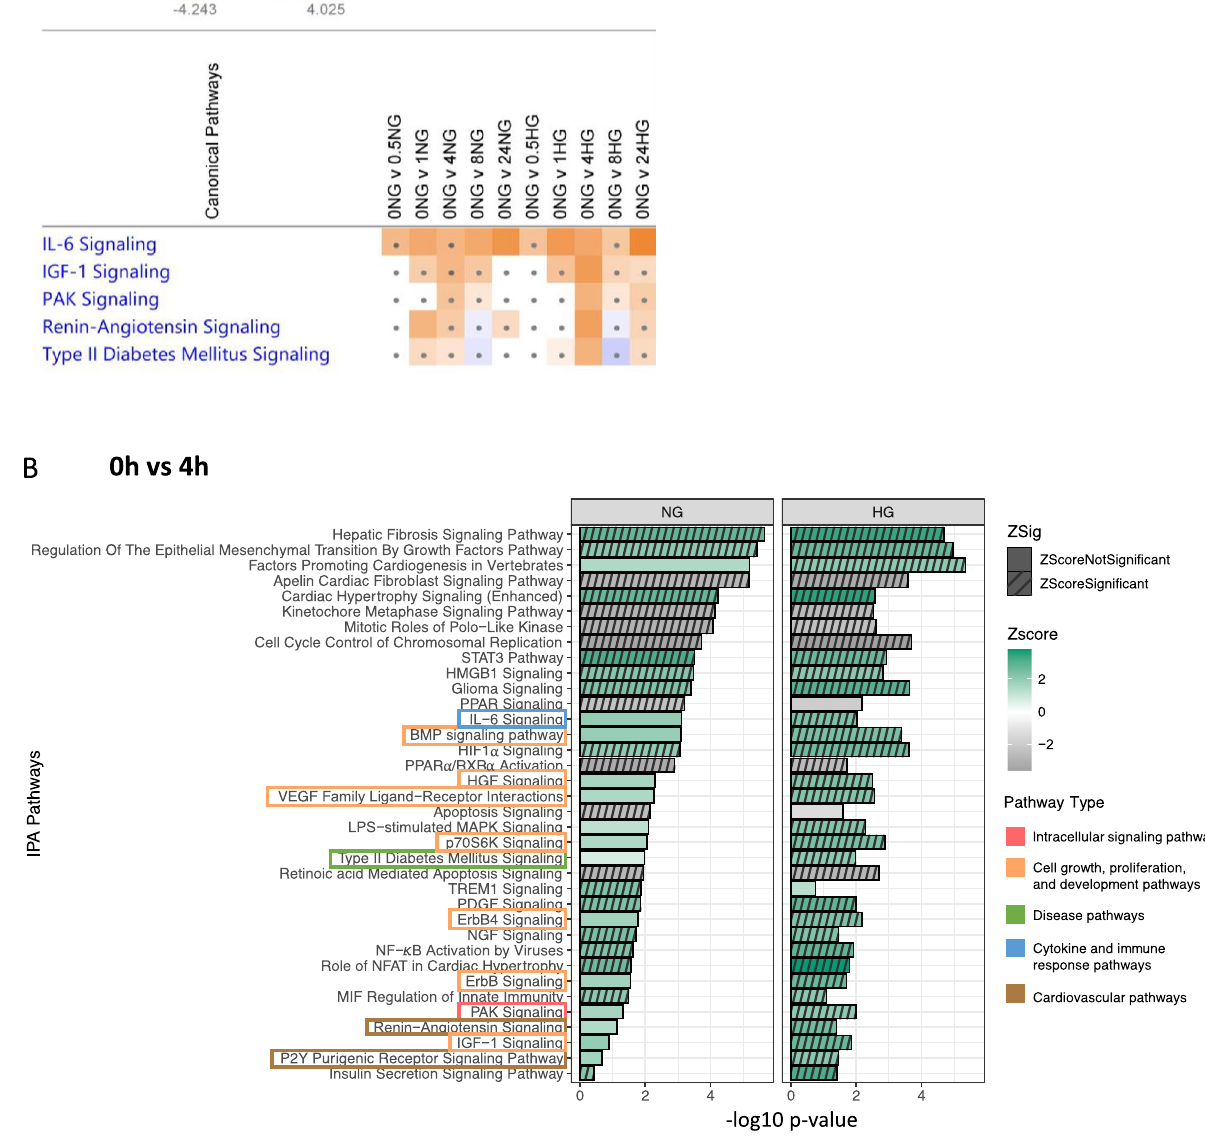
heat maps of the DEGs within these pathways (supplemental Fig. 6). Interestingly, the most differences between NG and HG conditions were observed at the 4 h time point where the number of activated/inhibited pathways